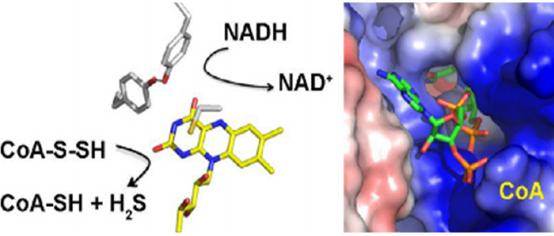
Figure 2 - Possible mechanism for disulfide reductase.